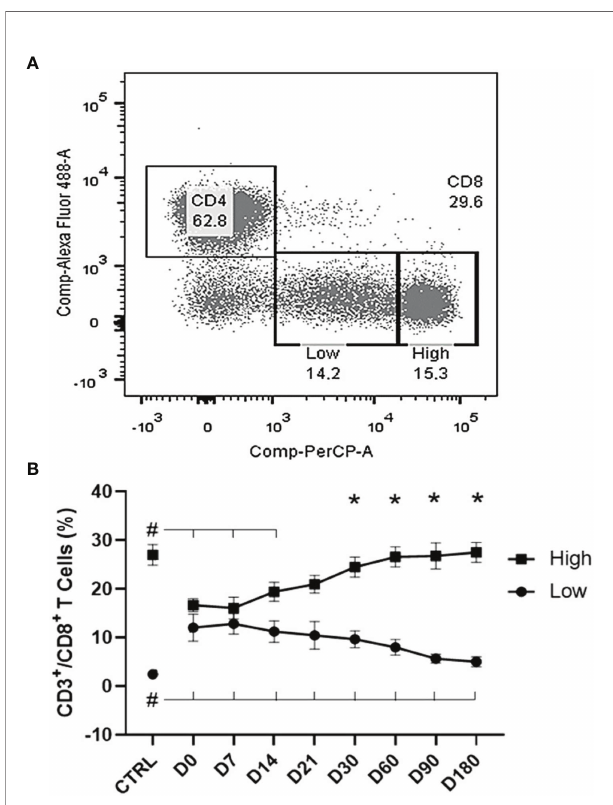
FIGURE 5 | Evolution of CD8 Low and T CD8 High T-cell populations. (A) Two subpopulations were gated within the CD8 + T cells according to their brightness intensity: CD8 High and CD8 Low in a visceral leishmaniasis (VL) patient before treatment. (B) Increases of CD8 High and decreases of CD8 Low T-cell frequencies along the treatment. Results are expressed as means ± SE values. The Shapiro – Wilk test disclosed that the distribution of frequencies was normal. Asterisks show the signi fi cant variations between CD8 High and CD8 Low populations starting from day 30, as disclosed by the two-way ANOVA Sidak analysis. Hashtags indicate signi fi cant differences between each time of treatment and healthy controls values as disclosed by Student ’ s t